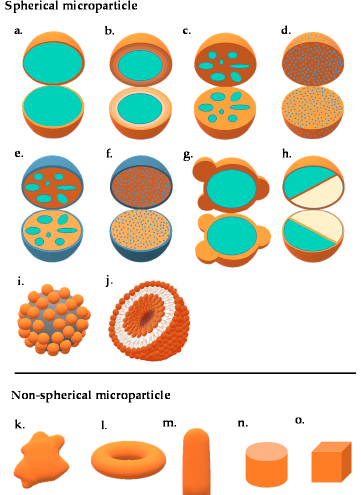
Figure 1. Schematic illustration of the di ff erent microparticle structures: ( a ) mononuclear / single core / core-shell, ( b ) multi-wall, ( c ) polynuclear / multiple core, ( d ) matrix, ( e ) coated polynuclear core, ( f ) coated matrix particle, ( g ) patchy microparticle, ( h ) dual-compartment microcapsule, ( i ) colloidosome, ( j ) giant liposome, ( k ) irregular-shaped microparticle, ( l ) torus-shaped microparticle, ( m ) bullet-shaped microparticle, ( n ) microtablet, and ( o ) cubic-shaped